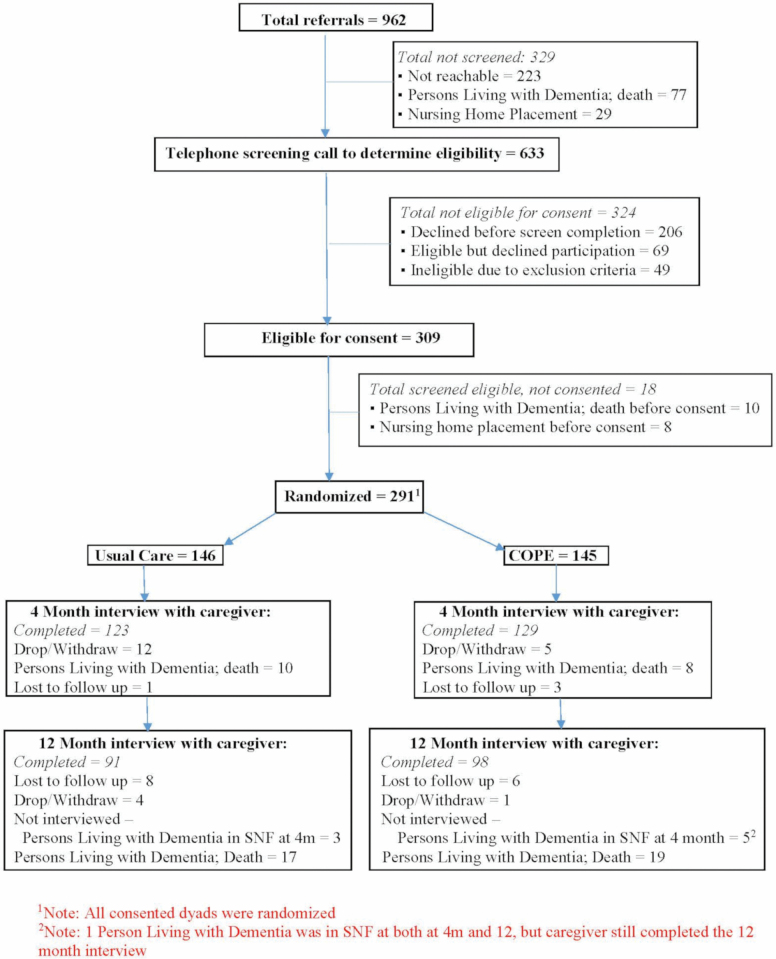
Study CONSORT chart.